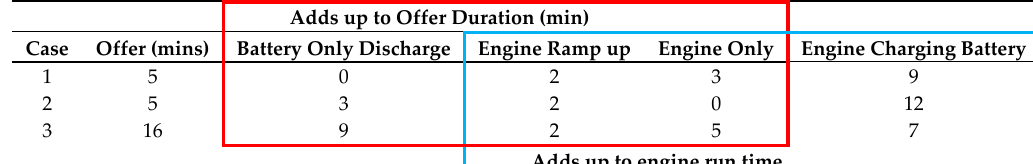
Table 6. Examples of operation.